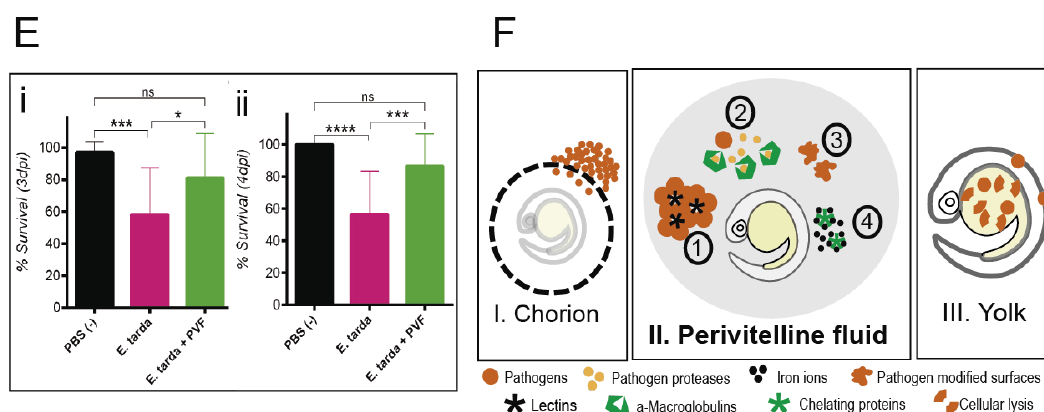
Figure 1. ( A ) The Venn diagram shows the number of exclusive and shared proteins present in the perivitelline fluid (PVF) at different stages: early blastula (yellow), at 1 dpf (purple) and 2 dpf (green). The 85 sequences present at all developmental stages are considered as constitutive of PVF composition. ( B ) Enriched protein classes (according to their Gene Ontology) detected in the PVF. The overrepresentation analysis reveals a marked overrepresentation of protein classes related to immune defense at all stages (Fisher’s test; p < 0.05). ( C ) Identity of proteins (or gene ID) present in the PVF during embryonic development and their presence (purple) or absence (yellow) at different stages. The presence of a protein at 0 dpf suggests a maternal origin, since samples were taken before the MBT; the absence of a protein at this stage suggests a zygotic origin, while the presence before and after MBT, suggests a mixed maternal-zygotic origin. The gene list associated with each protein found in the PVF was organized by their protein superfamilies, families, and / or molecular functions. For example, the A2M superfamily corresponds to the “serine protease inhibitors” in Figure 1B. ( D ) Zebrafish PVF can agglutinate live bacterial cells. The images show in vitro agglutination assays using fluorescent E. coli and S. typhimurium , which cluster in the presence of PVF. ( E ) PVF protects the zebrafish embryo from bacterial infection. Zebrafish embryos challenged at (i) 1 dpf and (ii) 2 dpf. The result reveals an augmented survival rate in the presence of PVF (Kruskal–Wallis test: **** p < 0.0001; *** p < 0.001; * p < 0.05). ( F ) The three main elements of early embryonic defense against pathogens in fish. The PVF constitutes the central element in a tripartite system of embryonic defenses against environmental pathogens. If an organism, chemical compound, or even a physical element from the exterior succeeds in crossing the chorion, it still must pass through the PVF to reach the